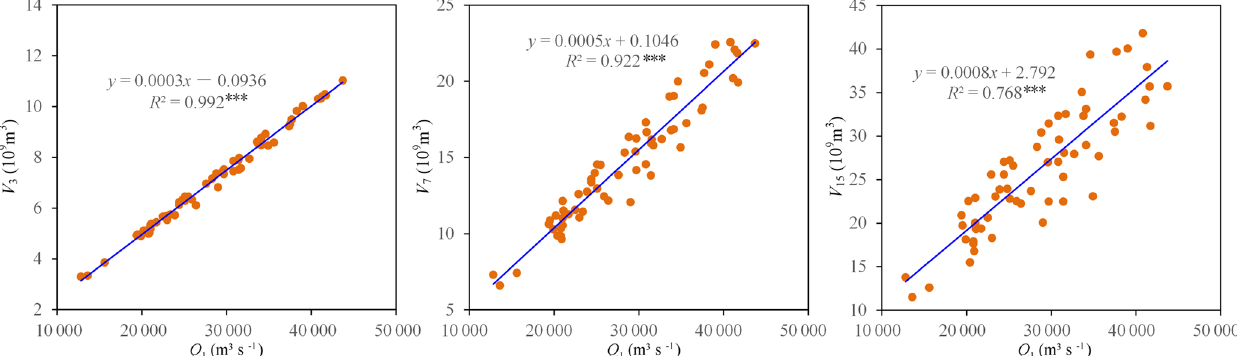
Figure 5. Statistical correlations between flood peak and flood volumes. Three asterisks (***) indicate the statistical correlation at the 0.01 significance